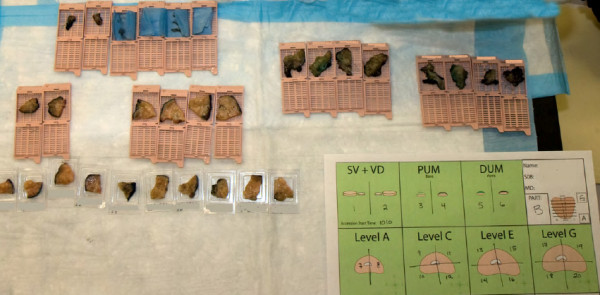
A photograph showing the labelled cassettes of prostate tissue from a single prostate specimen prior to snap freezing.